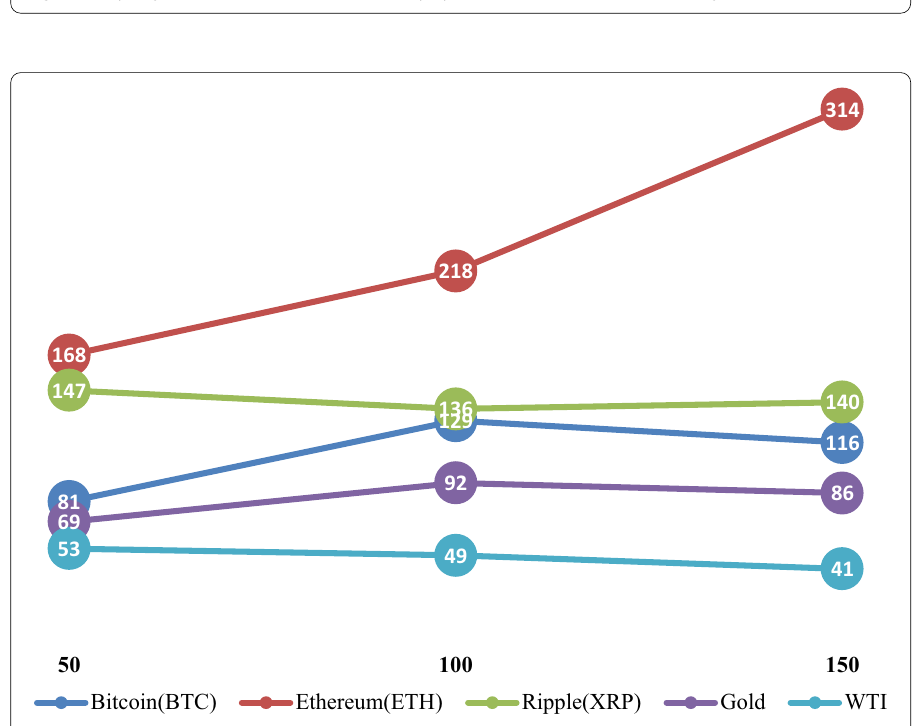
Fig. 4 Analyzing the behavior of market efficiency by GS tests statistics at 10 percent significant